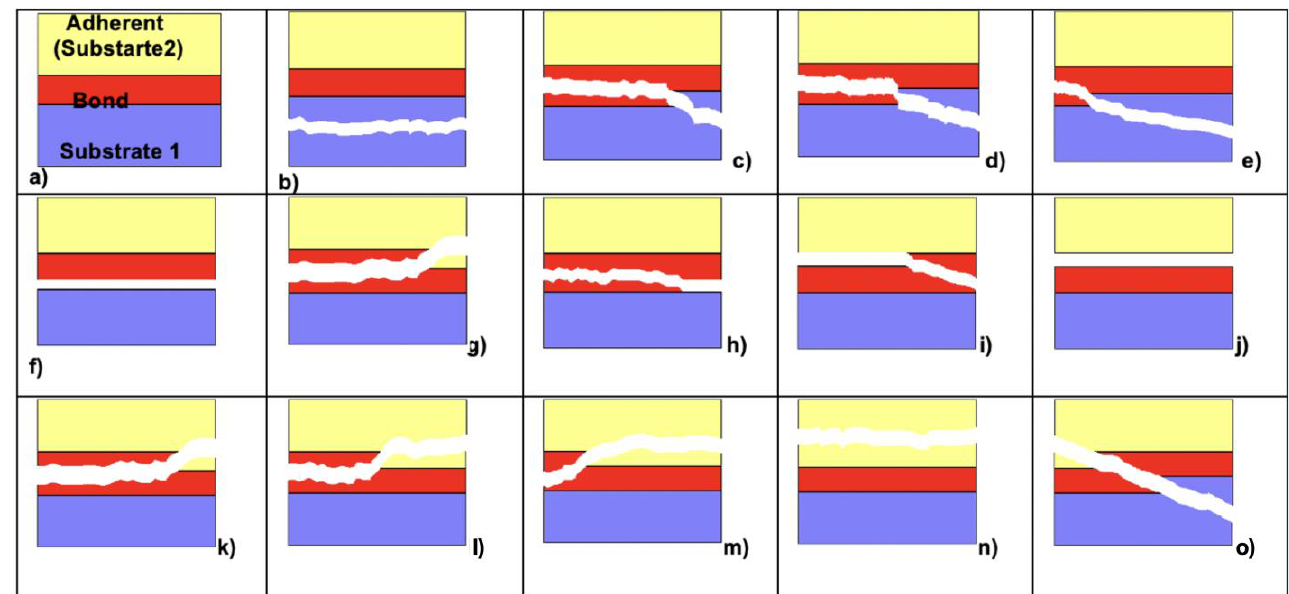
Figure 2. ( a – o ) Schematic sketch of 14 different evaluated failure types: ( a ) specimen before treatment, showing 3 different sections, upper layer is the adherent (substrate 2), the lowest one is the substrate 1, and both are bonded through a bond layer; ( b ) cohesive failure in substrate; ( c ) mixed cohesive failure in substrate and cohesive or adhesive failure in bond (>50% in bond); ( d ) mixed cohesive failure in substrate and cohesive or adhesive failure in bond (> or <50% in bond and 50% in substrate); ( e ) mixed cohesive failure in substrate and cohesive or adhesive failure in bond (>50% in substrate); ( f ) adhesive failure between substrate and bond; ( g ) mixed cohesive and adhesive failure in bond (>50%) adhesive failure between bond and substrate; ( h ) mixed cohesive and adhesive failure in bond (>50%) cohesive failure in bond; ( i ) mixed cohesive and adhesive failure in bond (>50%) adhesive failure between bond and adherent; ( j ) adhesive failure between bond and adherent; ( k ) mixed cohesive failure in adherent and cohesive or adhesive failure in bond (>50% in bond); ( l ) mixed cohesive failure in adherent and cohesive or adhesive failure in bond (> or <50% in bond and 50% in adherent; ( m ) mixed cohesive failure in adherent and cohesive or adhesive failure in bond >50% in adherent); ( n ) cohesive failure in adherent; (o) cohesive failure in substrate, bond, and adherent.